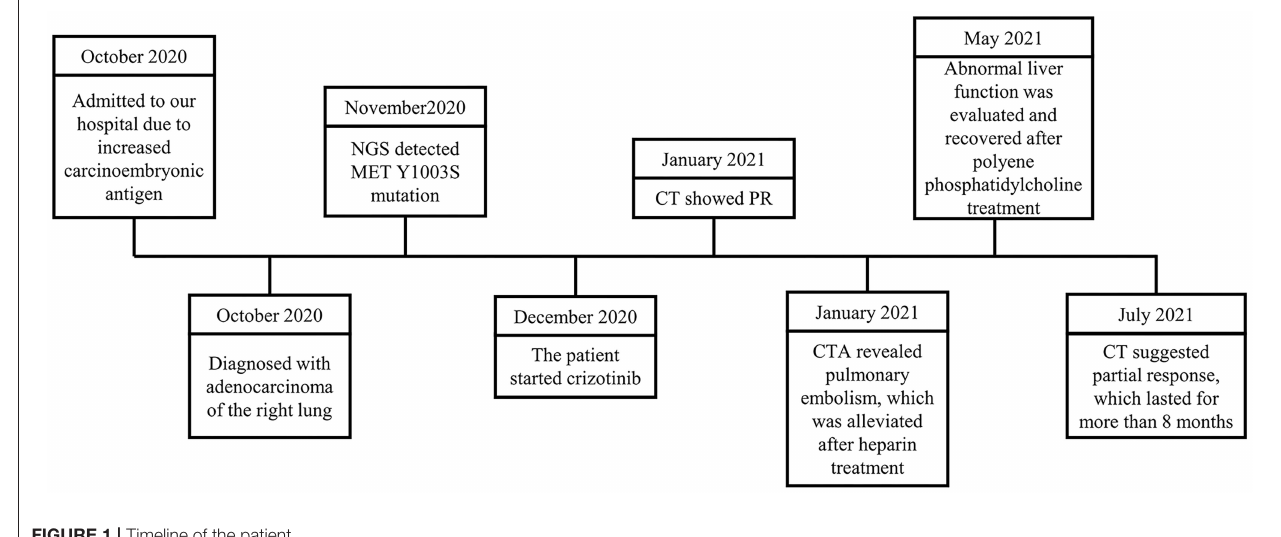
FIGURE 1 | Timeline of the patient.